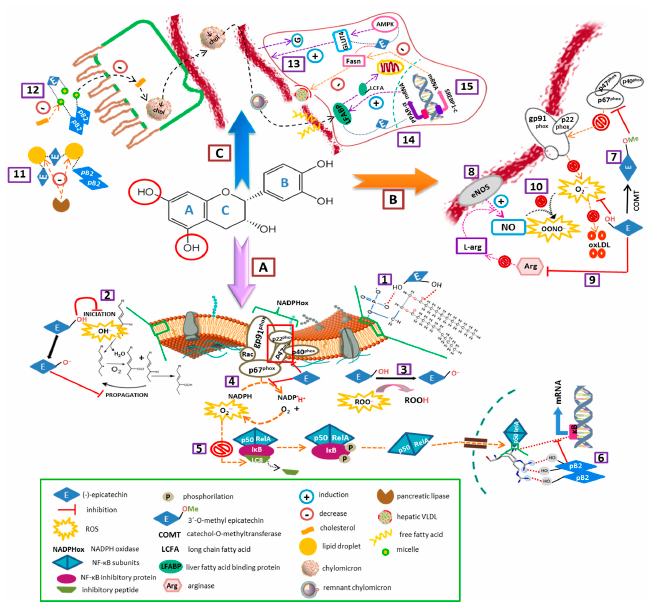
Figure 2. Mechanisms underlying the effects of cocoa (-)-epicatechin and procyanidin B2 on some of the major risk factors for developing metabolic syndrome. A and B mechanisms involved in flavanols antioxidant and anti-inflammatory effects. 1 The presence of both hydrophobic and hydrophilic domains in flavanol molecules allow them to be adsorbed on the polar head of membrane lipids and/or to interact with the hydrophobic chains of lipids inside the bilayer in order to modify membrane fluidity and permeability. 2 When inserted into the lipid bilayer, flavanols are in close proximity to scavenge free oxygen radicals (such as HO − ) and lipid soluble radicals (L − , LOO − ) derived from lipid peroxidation. 3 Scavenging free radicals is considered as one of the most important antioxidant mechanisms of flavanols, due to their OH groups (one-electron donation) and their aromatic structures (stabilization by resonance of the resultant radicals). 4 A high dose of epicatechin can prevent upregulation of nicotinamide dinucleotide phosphate NADPH oxidase subunits p47phox and p22phox, the increased enzyme complex activity and generation of O 2 − . 5 A decrease in cell reactive oxygen species (ROS) decreases the redox-sensitive release of the LC8 inhibitory peptide, preventing I κ B α phosphorylation and degradation and the release of the active NF- κ B complex. 6 Inside the nucleus, procyanidin B2 can mimic the guanine pairs in the κ B DNA sequence and establish hydrogen bonds similar to those that specifically interact with the arginine residues of both p50 and RelA. This inhibits the interaction of NF- κ B with κ B sites in gene promoters and dependent gene transcription. 7 3’-O-Methyl-(-)-epicatechin has shown to be an inhibitor of endothelial NADPH oxidase by blocking the translocation and interaction of p47phox/p67phox/p40phox with gp91phox and p22phox (transmembranal subunits). Thus, epicatechin improves bioavailability and bioactivity of NO in the arterial vascular endothelium. 8 Epicatechin can also increase circulating NO pool via eNOS activation. 9 (-)-epicatechin has shown to down-regulate endothelial cell arginase expression and activity. This leads to an increase in vascular L-arginine pool and substrate supply for the eNOS-catalyzed NO synthesis. 10 An adequate supply of L-arginine avoids eNOS uncoupling and formation of large quantities of O 2 − , which can scavenge NO to generate peroxynitrite or enhance the production of oxLDL. C. Mechanisms involved in flavanols hypolipidemic and hypoglycemic effects. 11 (-)-epicatechin and related flavanol oligomers may suppress triglyceride intestinal absorption by blocking the interaction between pancreatic lipase and the surface of emulsified lipid droplets. 12 Monomeric and oligomeric flavanols can lower plasma cholesterol concentrations by decreasing its solubility in intestinal micelles. 13 Cocoa flavanols could ameliorate hyperglycaemia by promoting translocation of GLUT4 in insulin-sensitive tissues via activation of AMPK signaling pathways. 14 Cocoa flavanols could also attenuate Non-alcoholic steatohepatitis (NASH) by increasing intracellular trafficking of (Long Chain Fatty Acid (LCFA) via liver fatty acid binding protein (LFABP) mRNA and protein expression. 15 In addition, cocoa flavanols may decrease fatty acid synthesis by down-regulation of the Fasn gene and protein